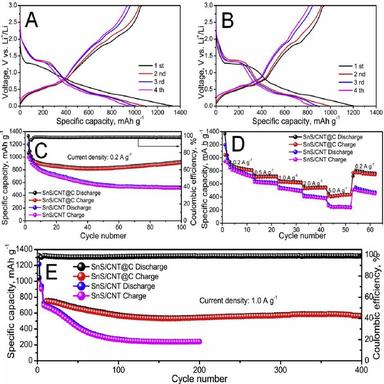
Electrochemical performance for LIBs: (A, B) Charge and discharge curves of SnS/CNT@C and SnS/CNT composite; (C) Cycle performance of SnS/CNT@C and SnS/CNT composite at 0.2 A g1 ; (D) Rate performance of SnS/CNT@C and SnS/CNT composite; (E) Long-term cycling performance of SnS/CNT@C and SnS/CNT composite at 1.0 A g1 .